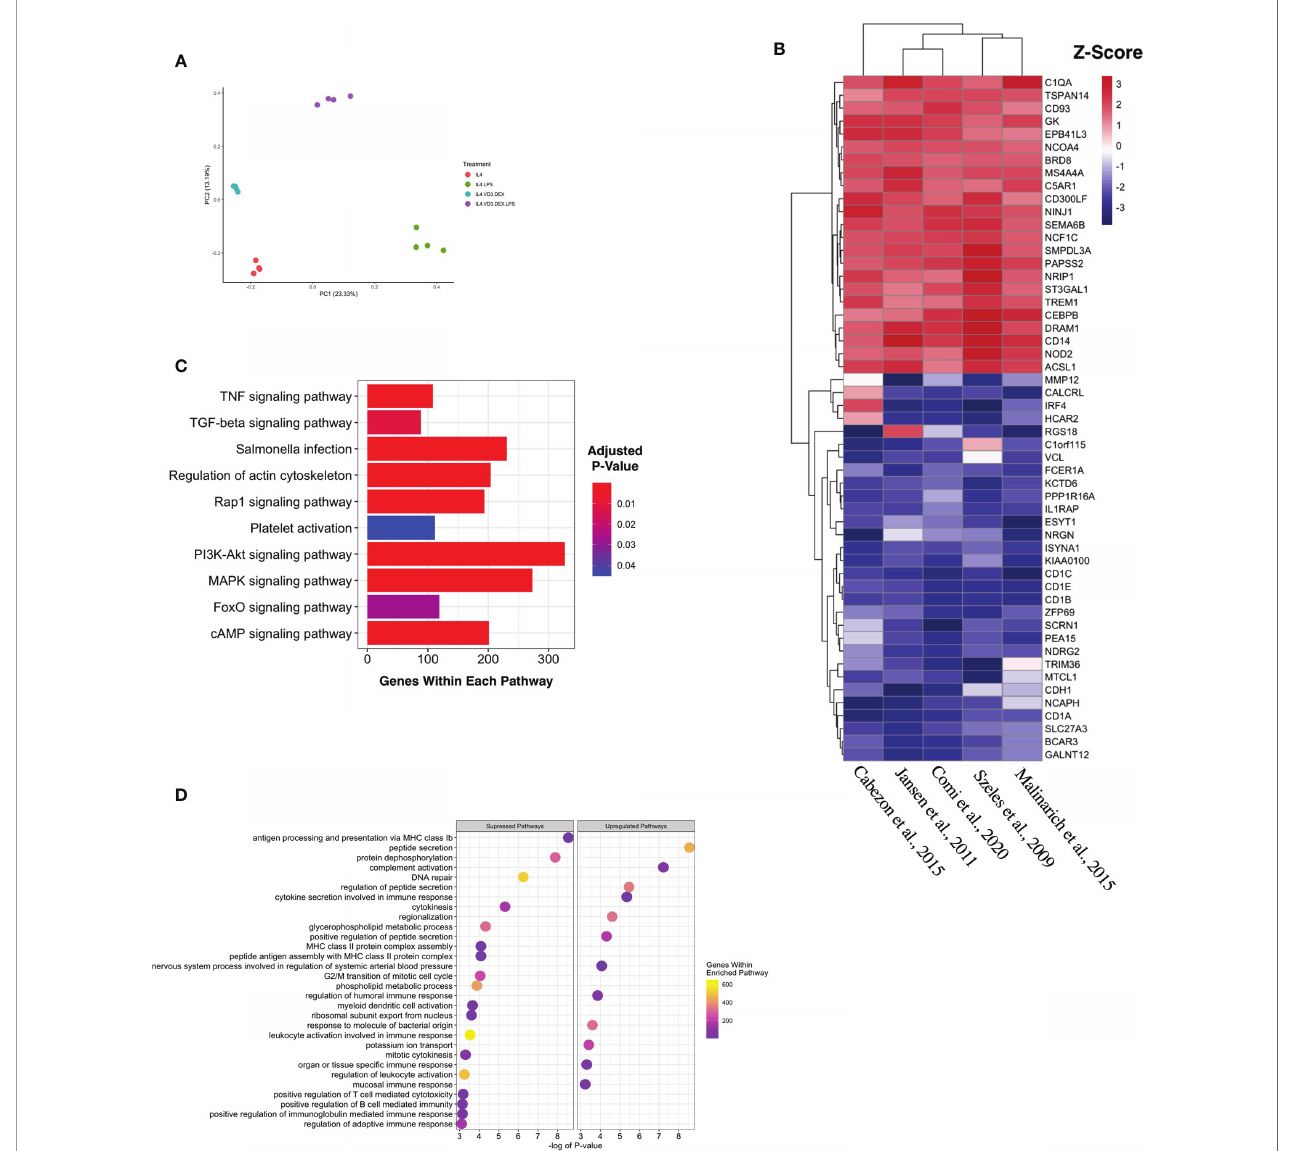
FIGURE 2 | Generating a unique tolDC transcriptome. (A) Principal component analysis (PCA) plot characterizing change in gene expression pro fi les between immature DC (red), mature DC (green), tolDC (blue), or alternatively-activated tolerogenic DC (AADC, purple) in GSE52894. Each dot presents a sample, and each color represents a DC phenotype. (B) Heatmap representation of the top 20 differentially expressed genes (DEG) by tolDC. DEG were arranged by hierarchical clustering on the vertical axis. Datasets, also clustered by hierarchical clustering, are displayed on the horizontal axis. The p-value yielded from each study were converted to z-scores and plotted. (C) KEGG and (D) Gene Set Enrichment analyses. Each point on the dot plot represents the number of genes involved in the relevant pathway. The gene ratio is the proportion of DEG versus genes not differentially expressed. Each point was colored to represent the adjusted p-value using the Benjamini-Hochberg